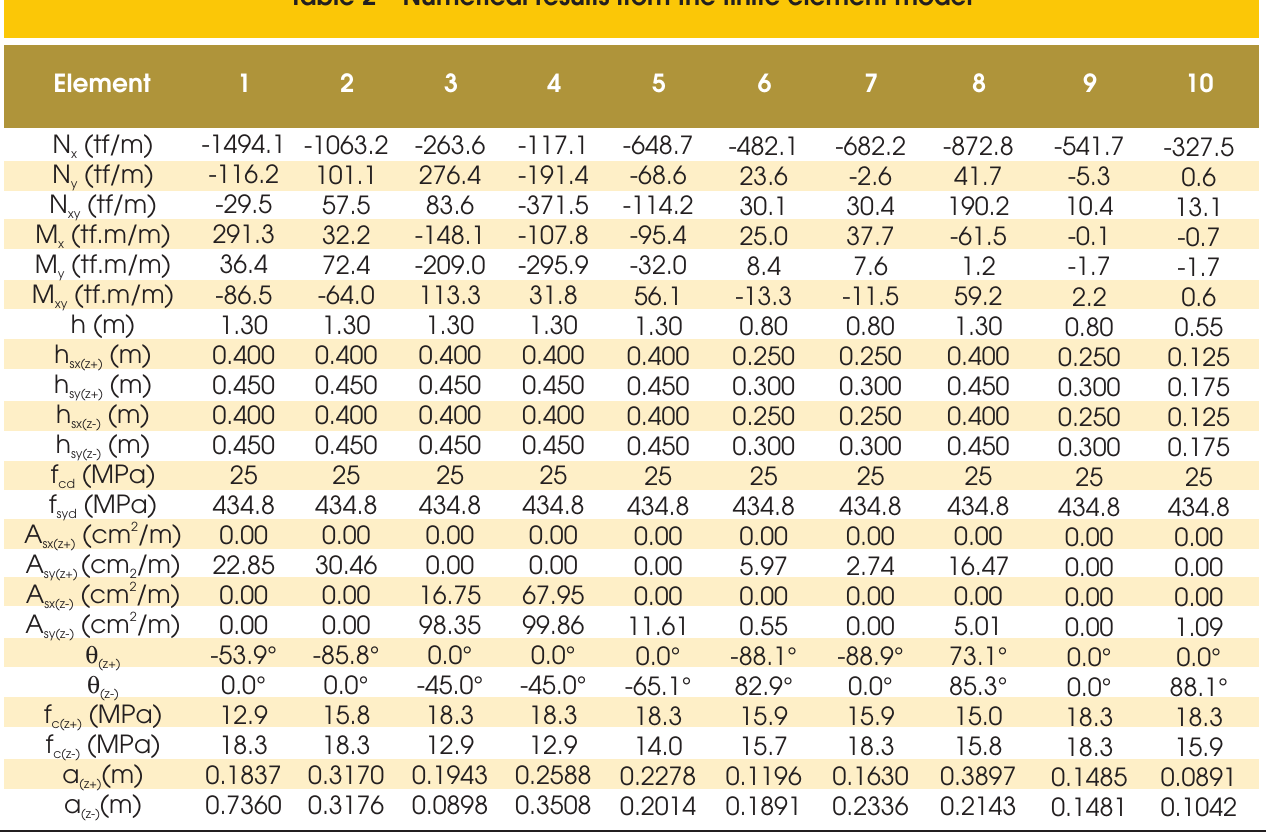
Table 2 – Numerical results from the finite element